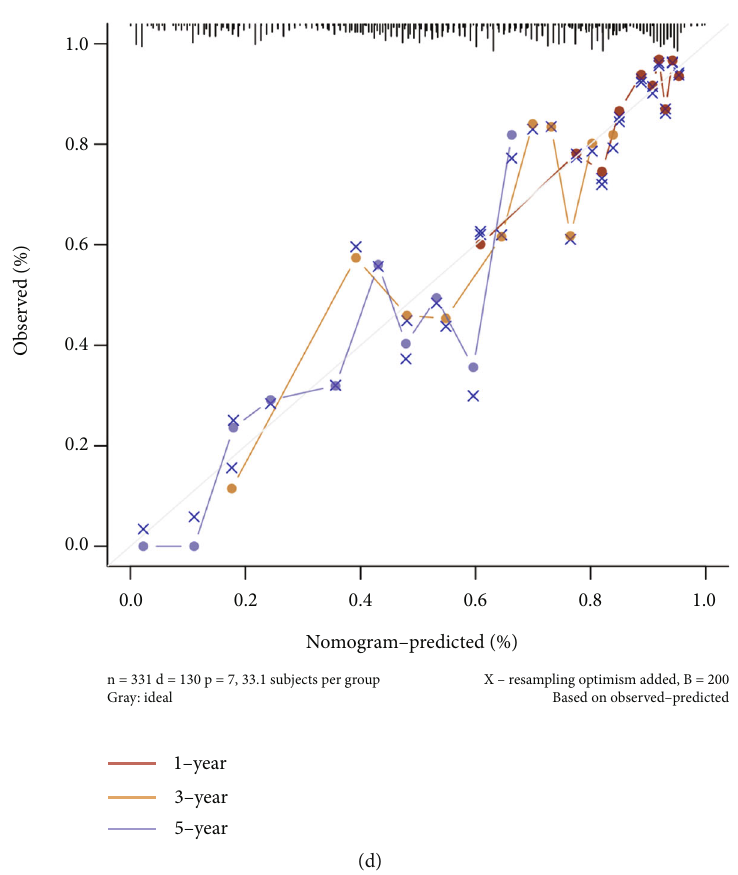
Figure 5: Construction of predictive nomogram. (a) and b) Univariate and multivariate Cox regression considering clinical parameters and necroptosis-related prognostic gene signature. (c) and (d) Nomogram to predict the 1-year, 3-year, and 5-year overall survival of LUAD patients. Calibration curve for the overall survival nomogram model in the discovery group. A dashed diagonal line represents the ideal nomogram. The word “ p ” means